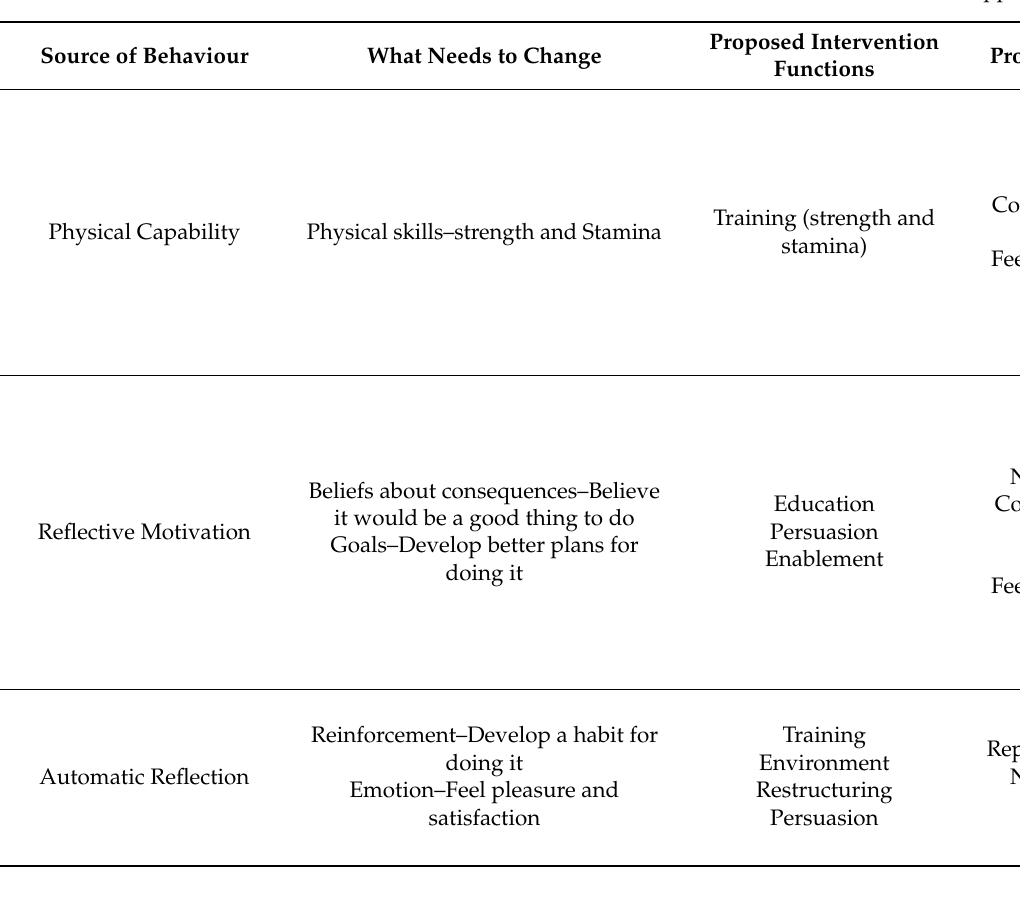
Table 1. Outcomes of the COM-B Self Evaluation Questionnaire mapped to Behaviour Change Technique (BCT) Taxonomy and Key Behaviour Change